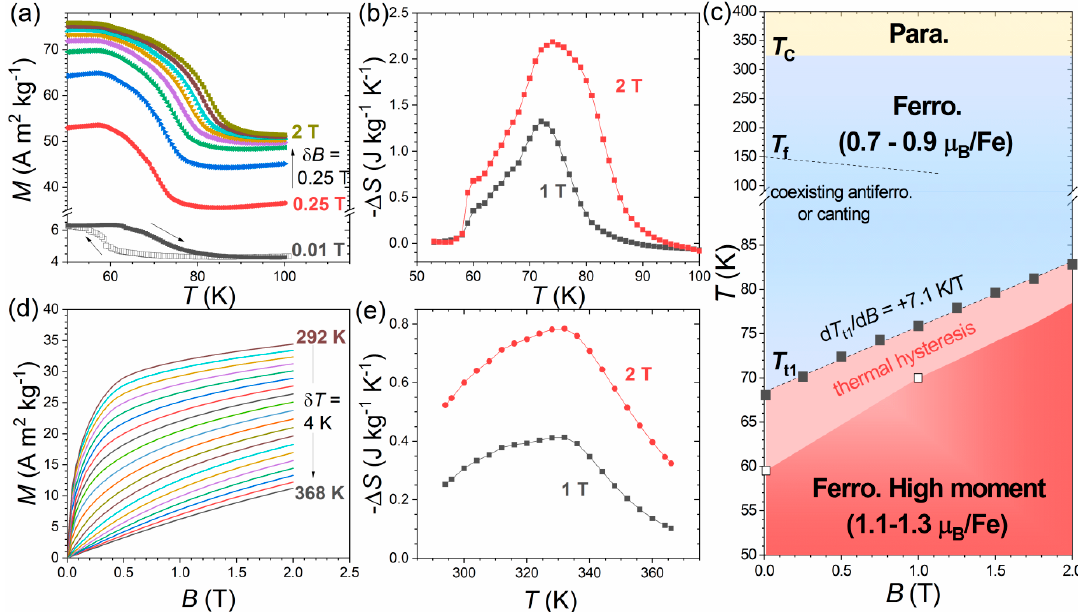
Figure 1. Temperature/field dependence of the magnetization and magnetocaloric effect of Sc 0.28 Ti 0.72 Fe 2 . ( a ) M B ( T ) curves measured upon heating (full symbols) and cooling (open symbol) around the first-order ferro-ferromagnetic transition T t1 ; ( b ) opposite of the isothermal entropy change near T t1 ; ( c ) magnetic phase diagram; ( d ) magnetization M T ( B ) curves at different temperatures near T C ; ( e ) opposite of the isothermal entropy change near T C .